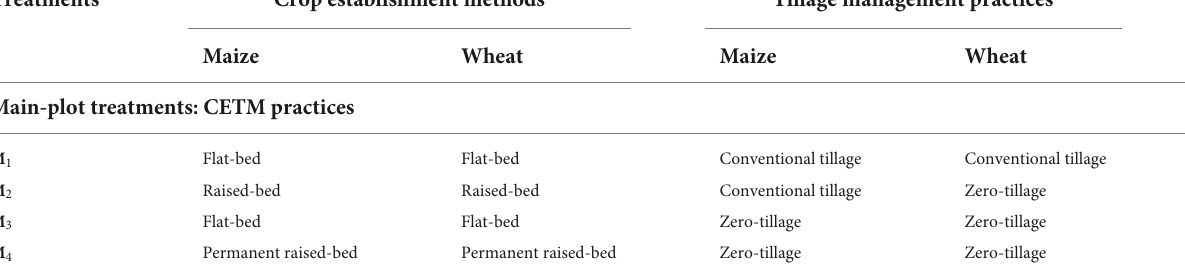
TABLE 2 Description of crop-establishment and tillage management (CETM) practices and P-fertilization practices in maize–wheat cropping system (MWCS). Treatments Crop establishment